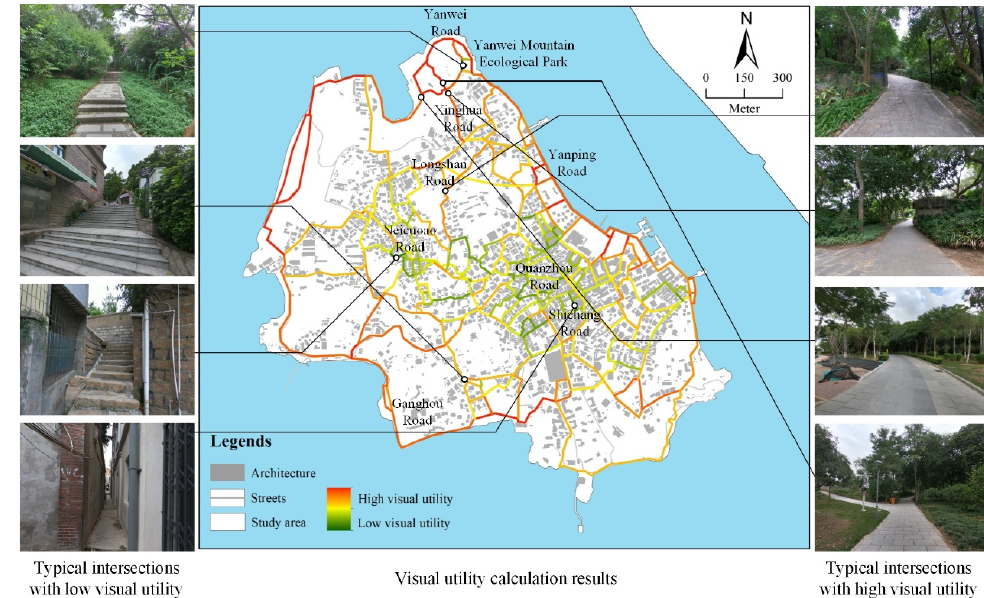
Figure 5. Visual utility and the typical intersections with high and low utility.